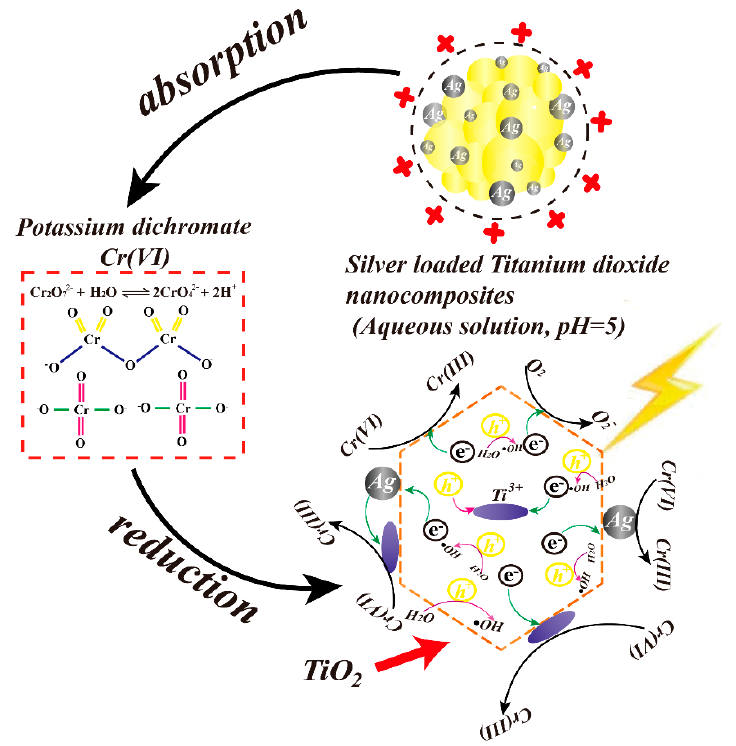
Figure 10. Mechanism of Cr(VI) photoreduction by ultra-trace Ag enhanced TiO 2 composites. 3. Materials and Methods.